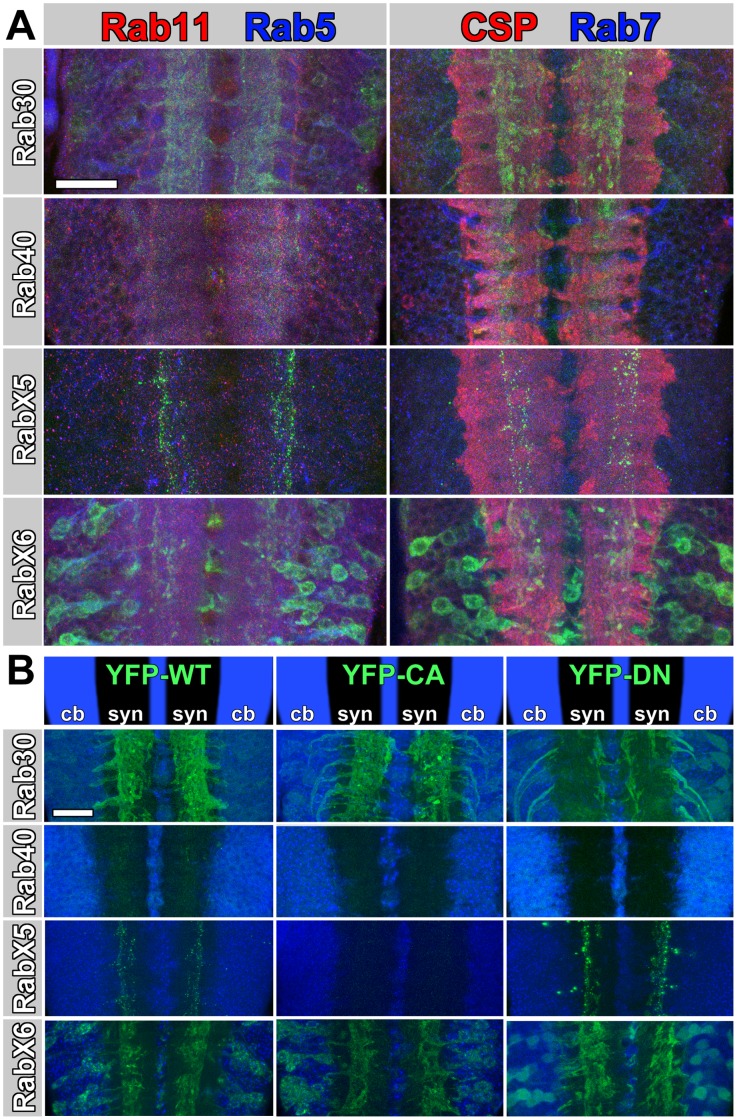
Subcellular Localization Features of YFP-Rab30, YFP-Rab40, YFP-RabX5, and YFP-RabX6.(A) Double immunolabelings of the posterior larval brain ventral ganglion at high resolution are shown for the four YFP-Rabs driven by their respective rab-Gal4 lines. Left column: YFP-Rab (green), anti-Rab11 (red, recycling endosomes), anti-Rab5 (blue, early endosomes); right column: YFP-Rab (green), anti-CSP (red, synaptic vesicles), anti-Rab7 (blue, late endosomes). Cell bodies are peripherally and synaptic neuropils centrally located. Scale bar for all panels represents 20 µm. (B) Corresponding Gal4-lines drive the expression of wild type YFP-tagged Rabs in the left column, constitutively active (GTP-bound) YFP-tagged Rabs in the middle column and dominant negative (GDP-bound) YFP-tagged Rabs in the right column. Toto-3 labels nuclei (blue). Scale bar for all panels represents 20 µm.